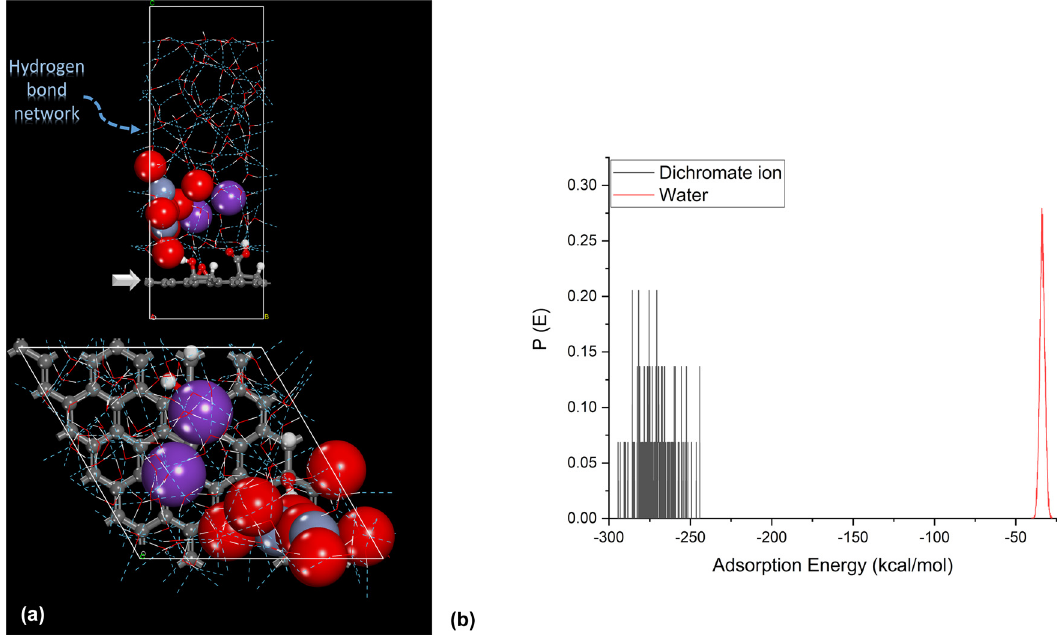
Figure 5: ( a ) Side and top views of the equilibrium adsorption con fi gurations of the dichromate ions ( one dichromate ion + 100 water molecules ) onto the GO model ( 5 × 5 graphene layer containing: an epoxy, carboxy, and hydroxyl functional groups on its surface obtained using MC simulations ) and ( b ) adsorption energy distributions for dichromate ions.